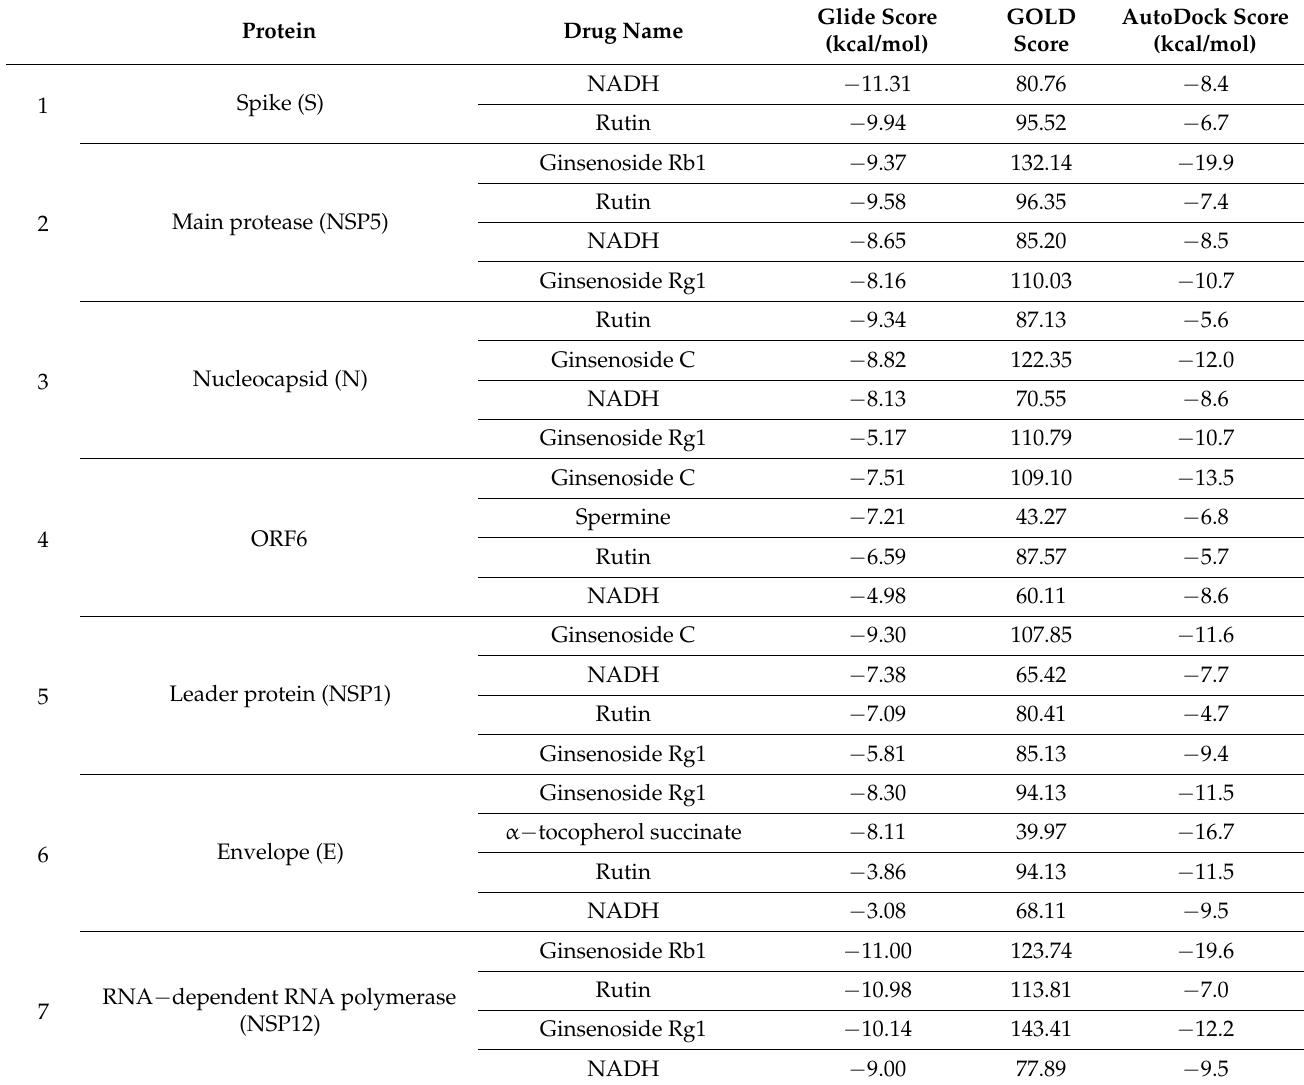
Table 2. Virtual screening results of nutraceuticals against SARS-CoV-2